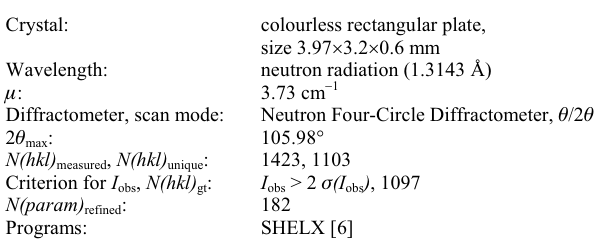
Table 1. Data collection and